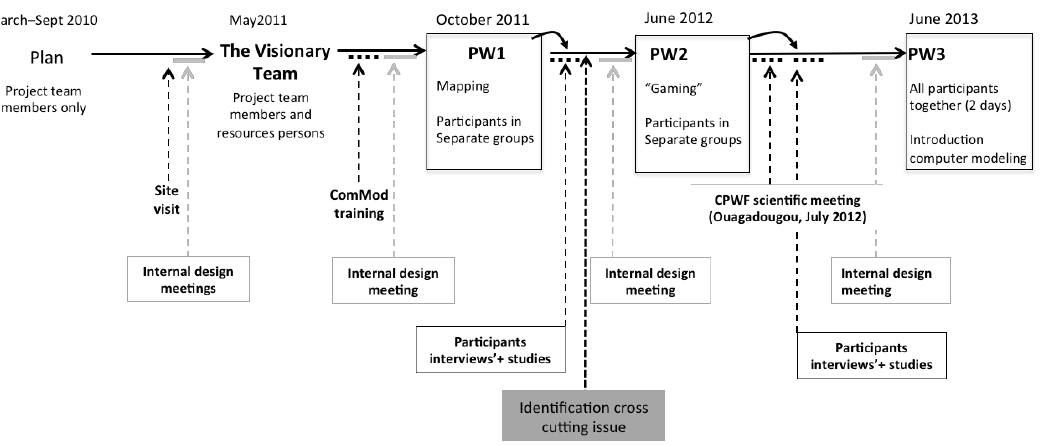
Figure 2. The main steps of the multi-level participatory process facilitated by the Challenge Program for Water and Food (CPWF) V4 project.